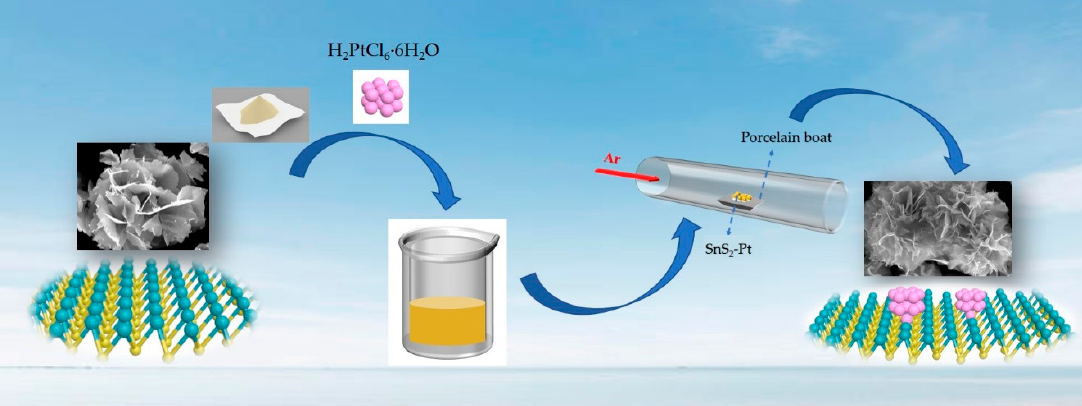
Figure 1. Synthesis diagram of ultra-thin SnS 2 -Pt-3 nanosheets.